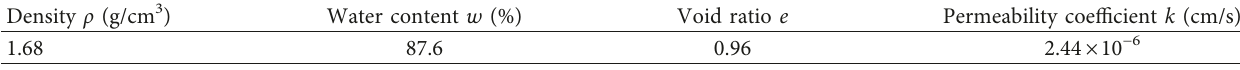
Table 1: Physical properties of the BTs.